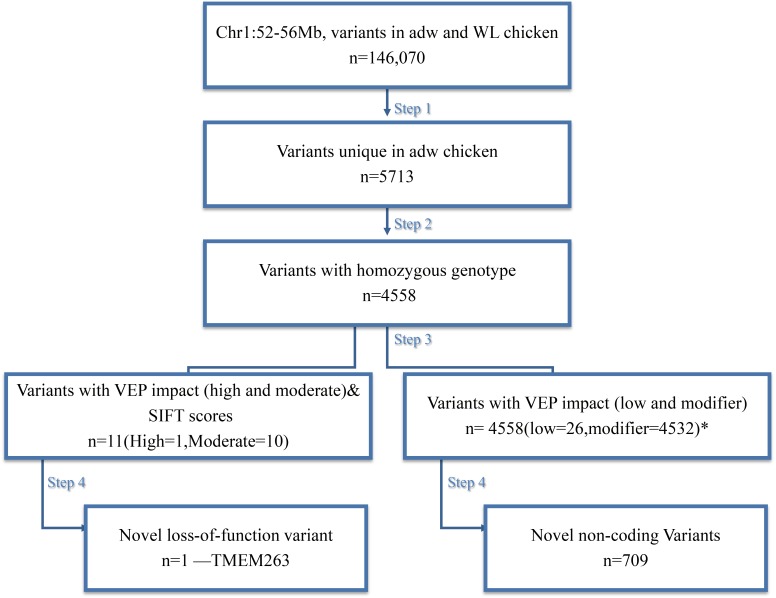
Schematic representation of the four steps filtering to identify the candidate variant for the chicken adw locus. n = number of variants after each filtering step. Autosomal dwarfism is represented by adw, while WL is the White Leghorn Chickens. After the filtering, there is one candidate SNP exclusively found in adw and with a high impact on the consequence, shown at the left path. While there is a list of variants also uniquely fond in the adw chicken, they are mainly located on the non-coding region, shown at the right path. During variant impact prediction, each variant could have more than one impact assigned, as the impact estimation was based on different transcript. ∗Note that among these variants, 11 of them contain more than one impact. The sum of variant numbers therefore is not consistent with the result from the last step.